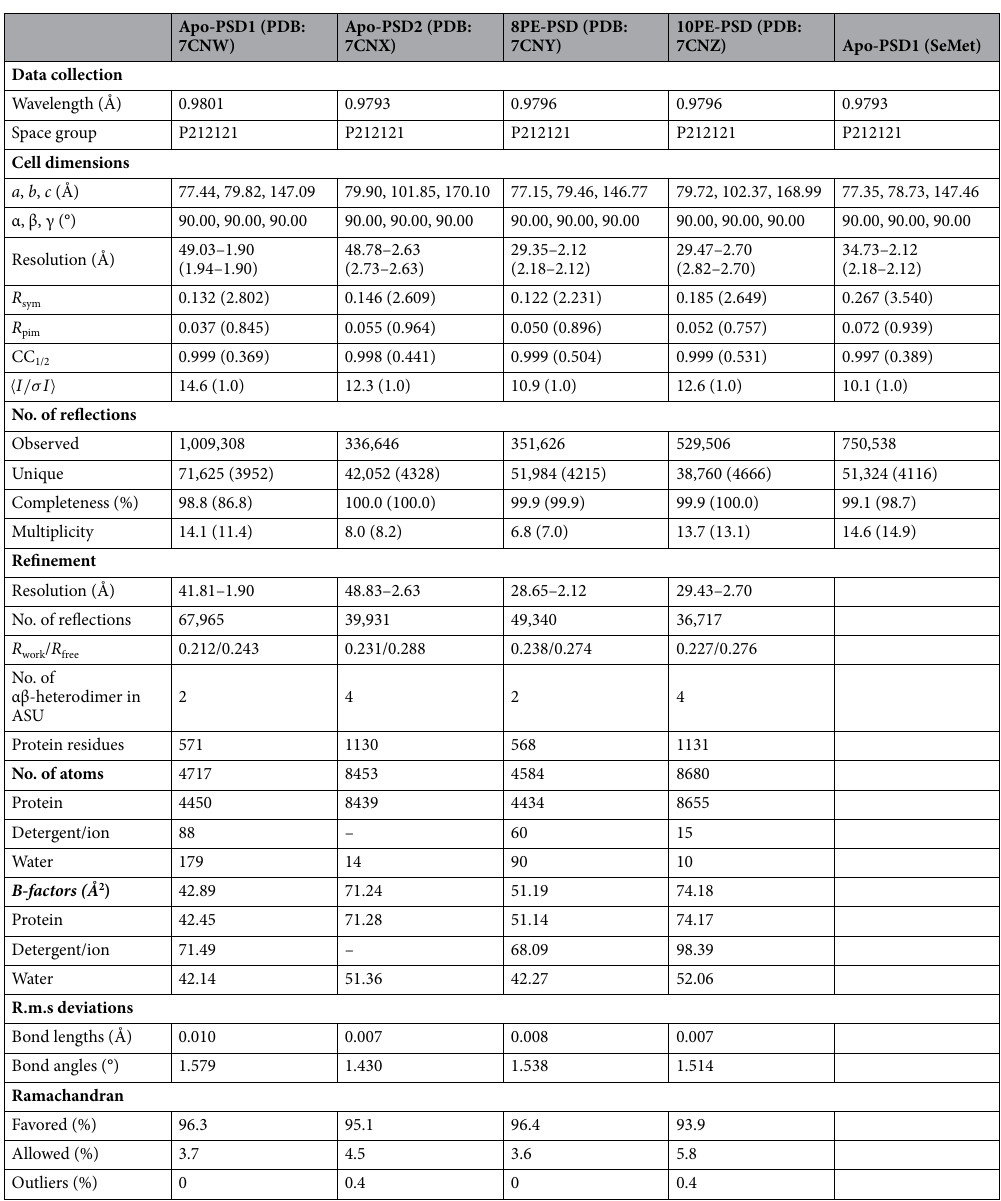
(Fig. 2B). The N-terminal pyruvoyl residue (Pvl-254) of the α-subunit was unambiguously identified in both apo structures (Fig. 2C). Gly-253 of the β subunit, which is no longer connected to Pvl-254 after auto-cleavage, is approximately 12.6 Å apart when the distance between two C α s is measured, and it forms a salt bridge with the side chain of Arg-221. Consequently, Pvl-254, which is located at the base of the funnel-shaped active site, is open for substrate binding (Fig.